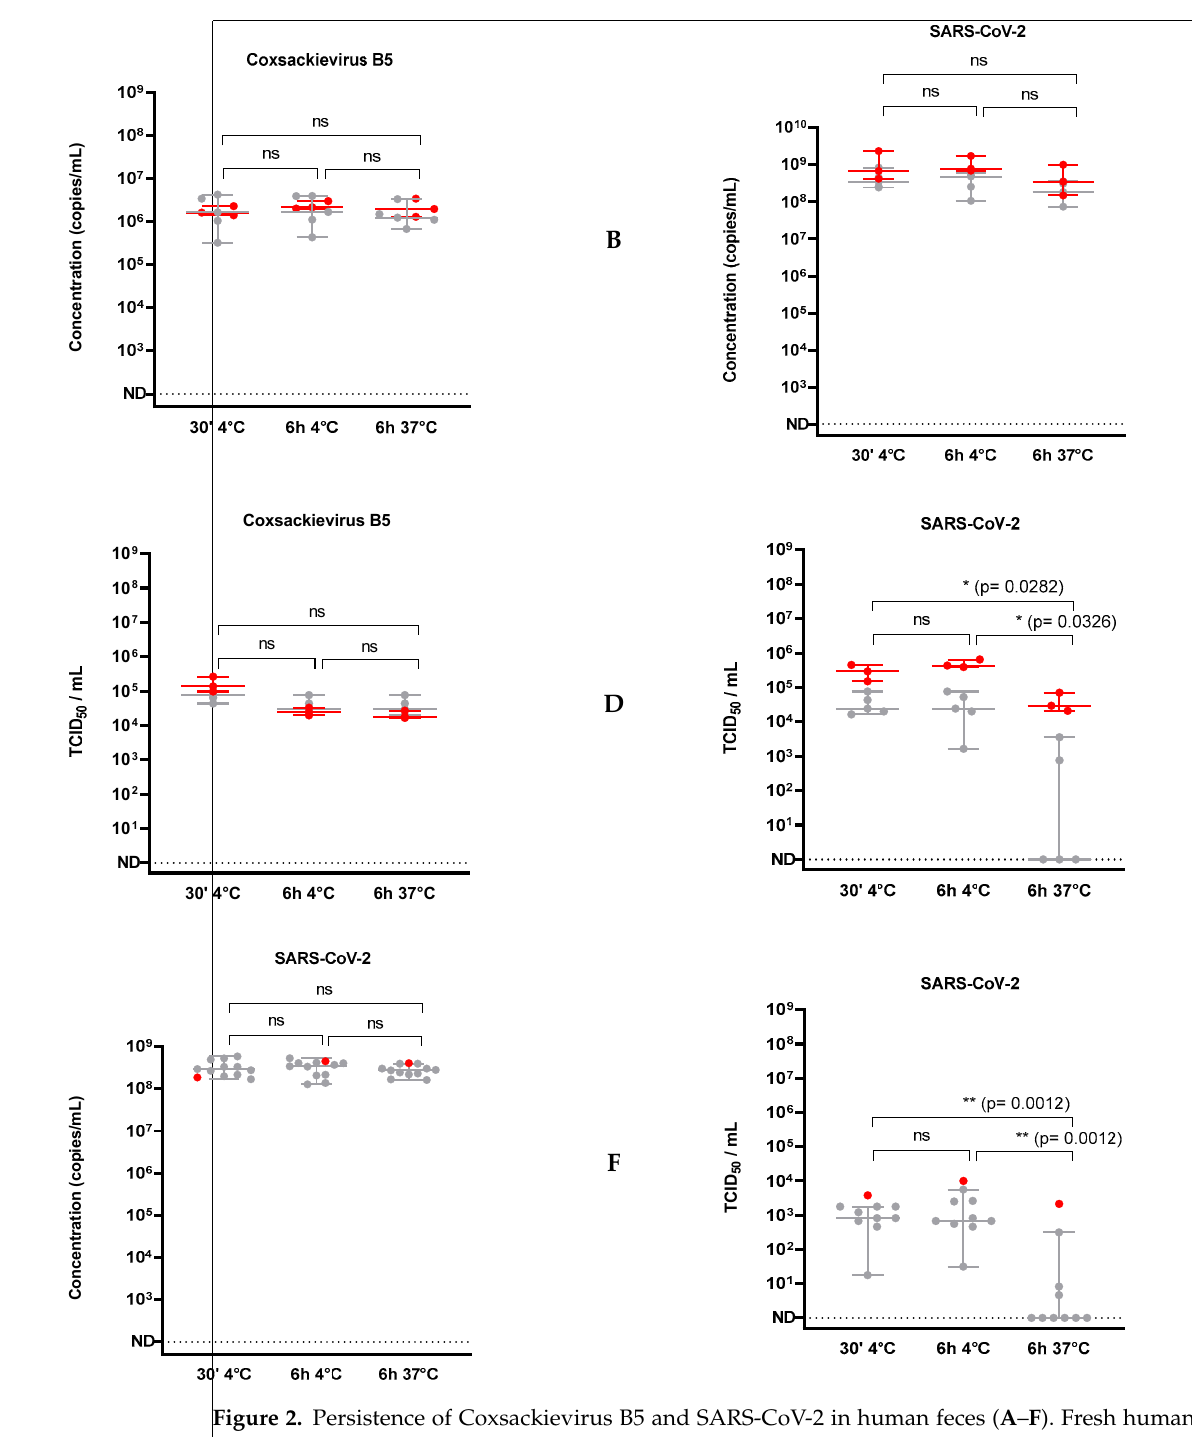
Figure 2. Persistence of Coxsackievirus B5 and SARS-CoV-2 in human feces ( A – F ). Fresh human feces (grey) were inoculated with infectious viral suspension compared to cell culture medium (red) for up to 6 h. Titration of Coxsackievirus B5 (panel ( C )) or SARS-CoV-2 (panel ( D )) was done by endpoint plaque assay. Infectious Coxsackievirus B5 concentration did not show any significant change in spiked feces samples. Persistence of viral RNA (panel ( E )) or infectious particles (panel ( F )) of SARS-CoV-2 in feces from African negative donor was analyzed. Statistical tests were considered as positive if p -value < 0.05. *: p -value < 0.05; **: p -value < 0.01. ns = not